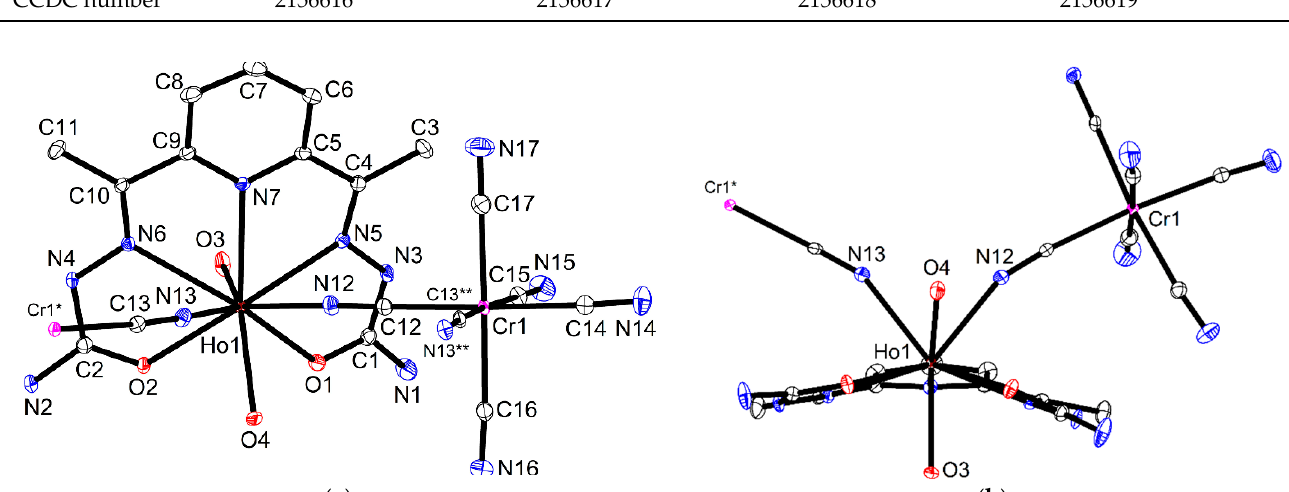
Figure 2. Asymmetric unit in 3 with atom numbering scheme, ( a ) top and ( b ) side view, ORTEP drawing with 50% probability ellipsoids). Symmetry codes: * (1 − x , 0.5 + y , 0.5 − z ), ** (1 − x , y − 0.5, 0.5 − z ).